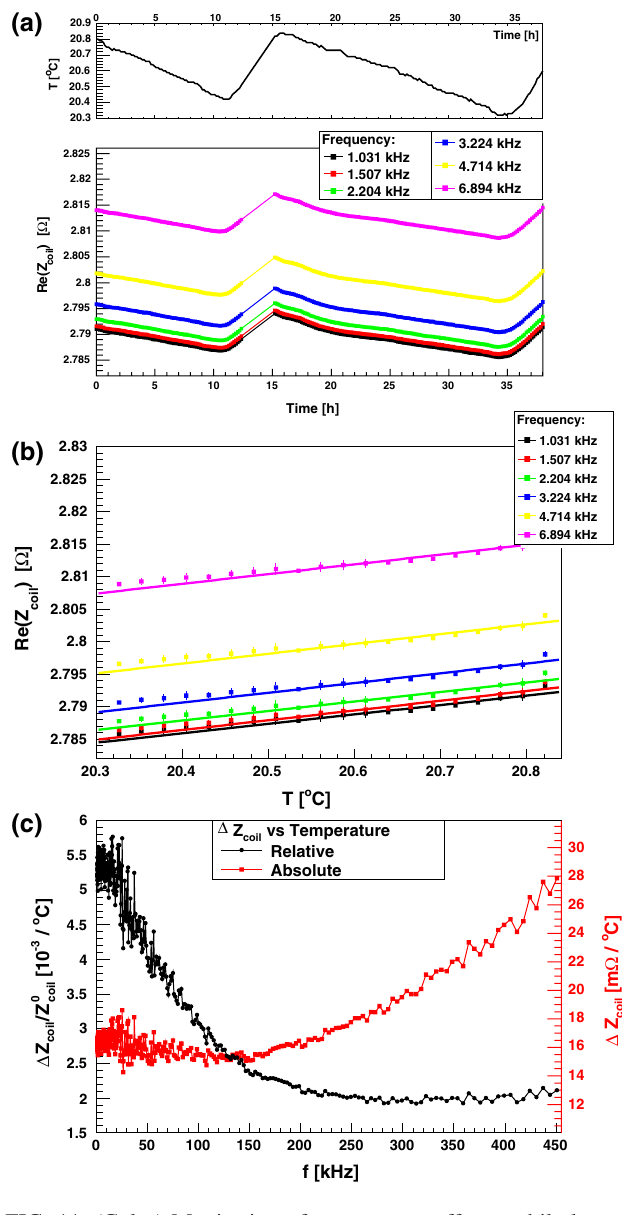
FIG. 11. (Color) Monitoring of temperature effects, while leav- ing a probe coil inserted between two graphite jaws ( L ¼ 1 : 2 m , gap ¼ 1 cm ) for about 38 hours (234 measurements): (a) laboratory temperature (top) and real part of the coil imped- ance at six frequency samples from 1 to 7 kHz (bottom) as a function of time; (b) real part of the coil impedance as a function of temperature at six frequency samples from 1 to 7 kHz. Dots are measurements while the solid lines are the linear fit used to calculate the temperature coefficients below; (c) temperature coefficient as a function of